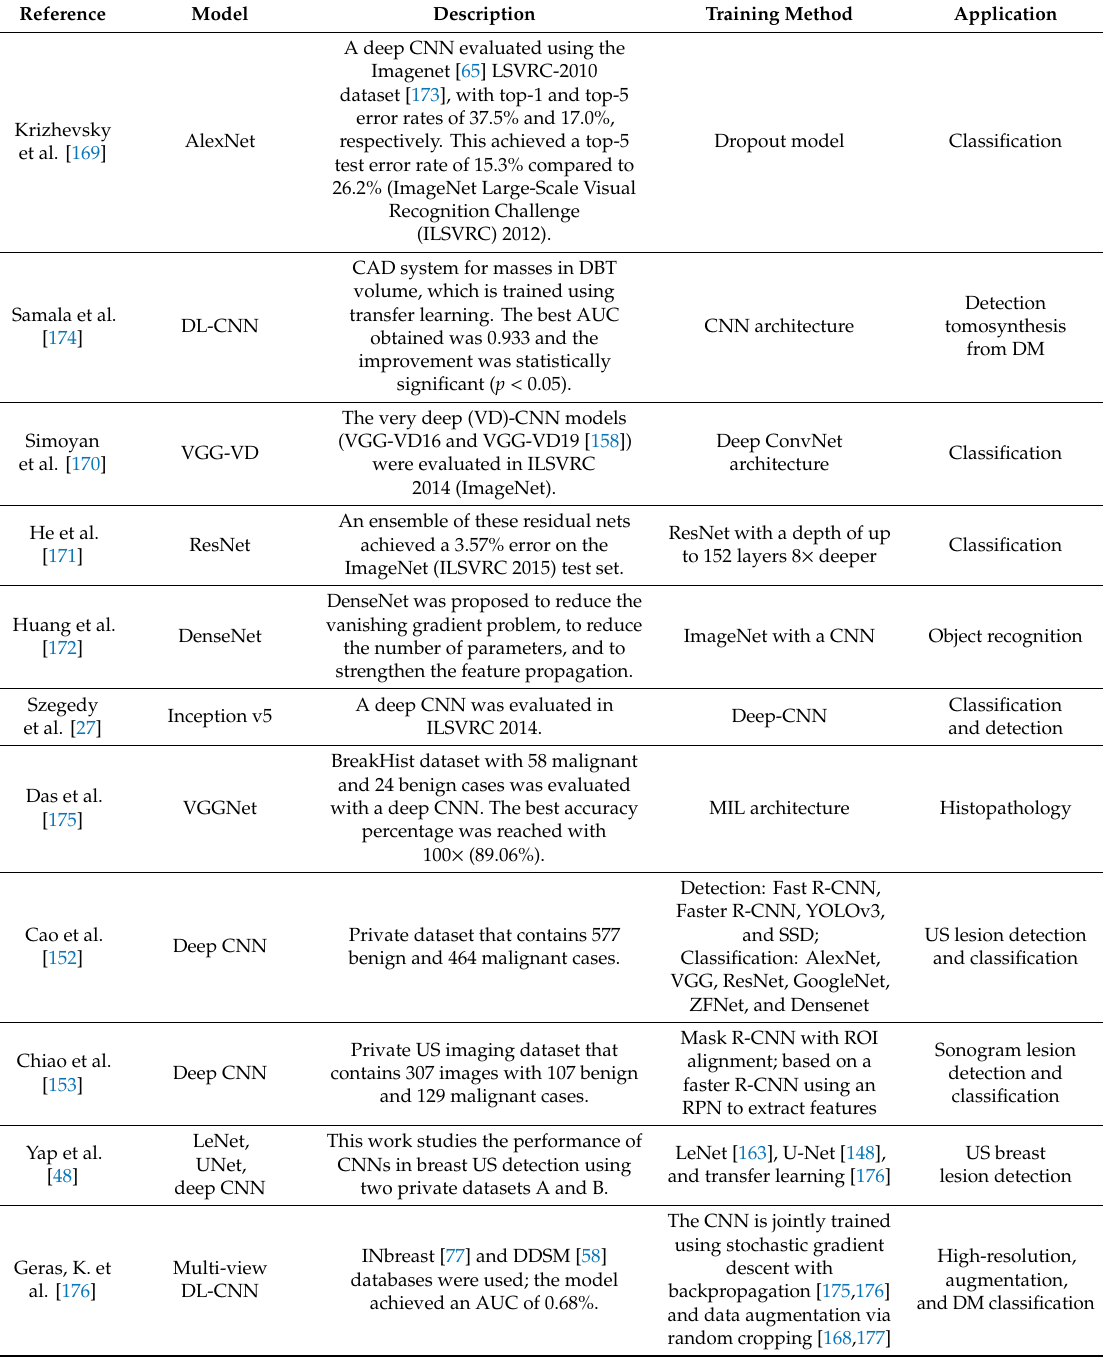
Table 5. Summary of CNN architecture information for breast imaging